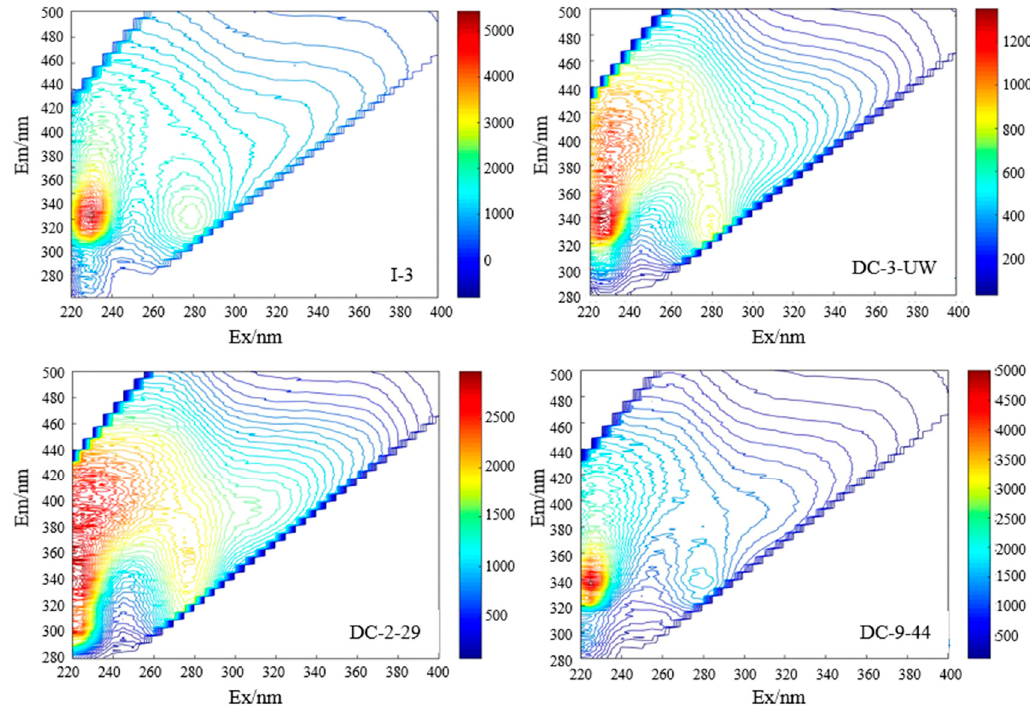
Figure 2. Examples of the fluorescence spectra of surface, underlying, and sediment pore waters collected from Dianchi Lake in different sampling points. I-3: third inlet river (Figure 1); DC-3-UW: underlying water of DC-3 site; DC-2-29: water from 29 cm in the sediment of DC-2; DC-9-44: water from 44 cm in the sediment of DC-9; Ex: excitation wavelength; Em: emission wavelength.